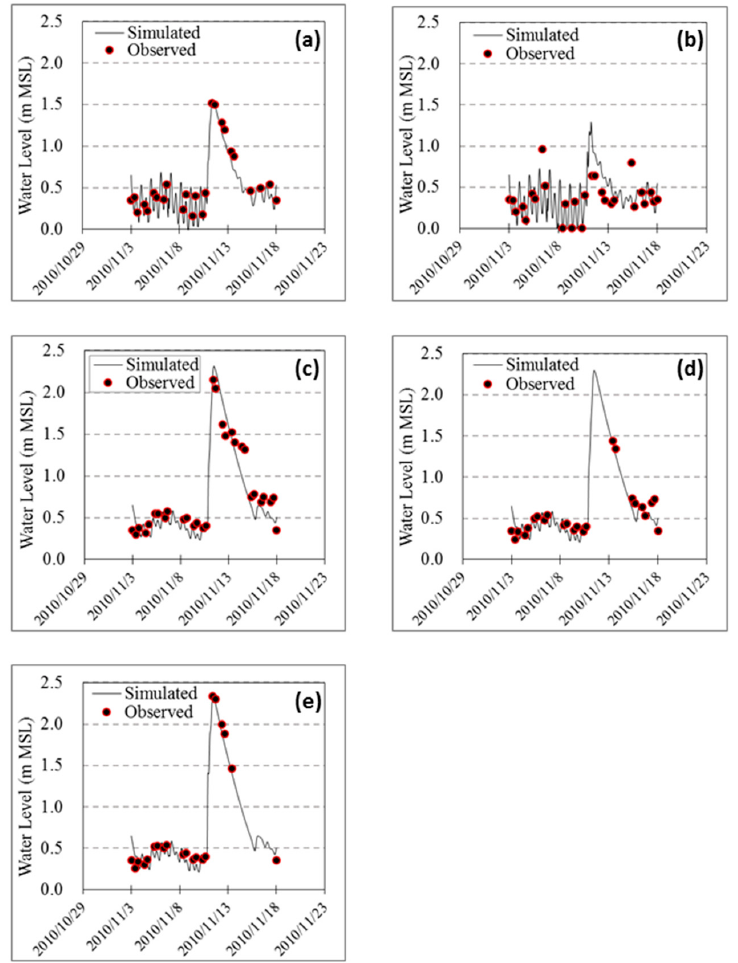
Figure 8. Water level comparison for the model calibration: ( a ) Galle Road Bridge in Wellawatta canal; ( b ) Galle Road Bridge in Dehiwela canal; ( c ) SLLRDC Bridge in Heen Ela canal; ( d ) Kirimandala Bridge in Heen Ela canal; ( e ) Railway Bridge in Torrington canal.